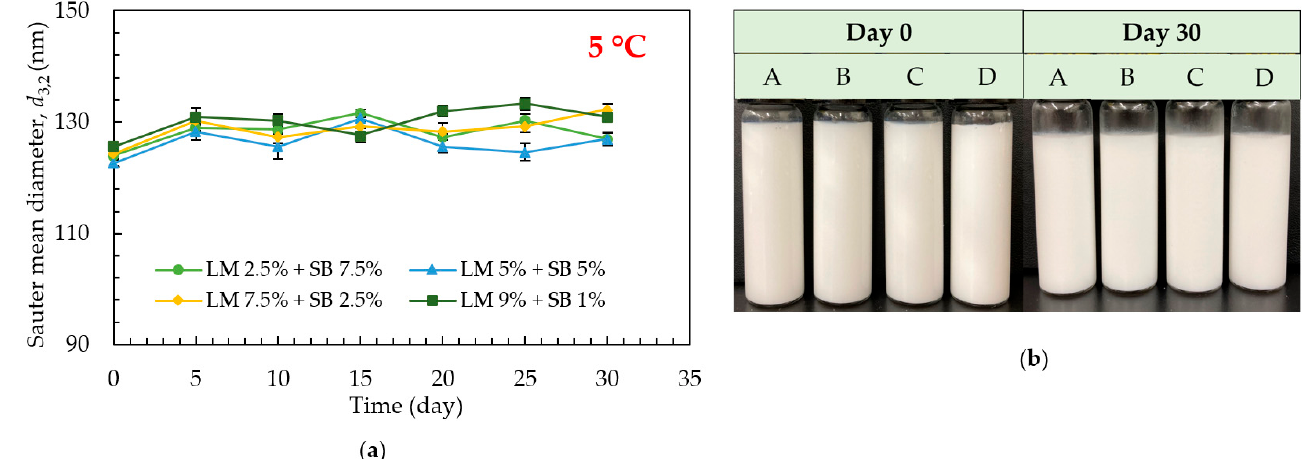
Figure 3. Effect of storage time, temperature, and SB concentration on the physical stability of the emulsions loaded with LM during 30 days of storage at 5 °C. ( a ) Sauter mean diameter ( d 3,2 ) and ( b ) The photos of the emulsions on days 0 and 30 where A: LM 2.5% + SB 7.5%, B: LM 5% + SB 5%, C: LM 7.5% + SB 2.5%, and D: LM 9% + SB 1%.